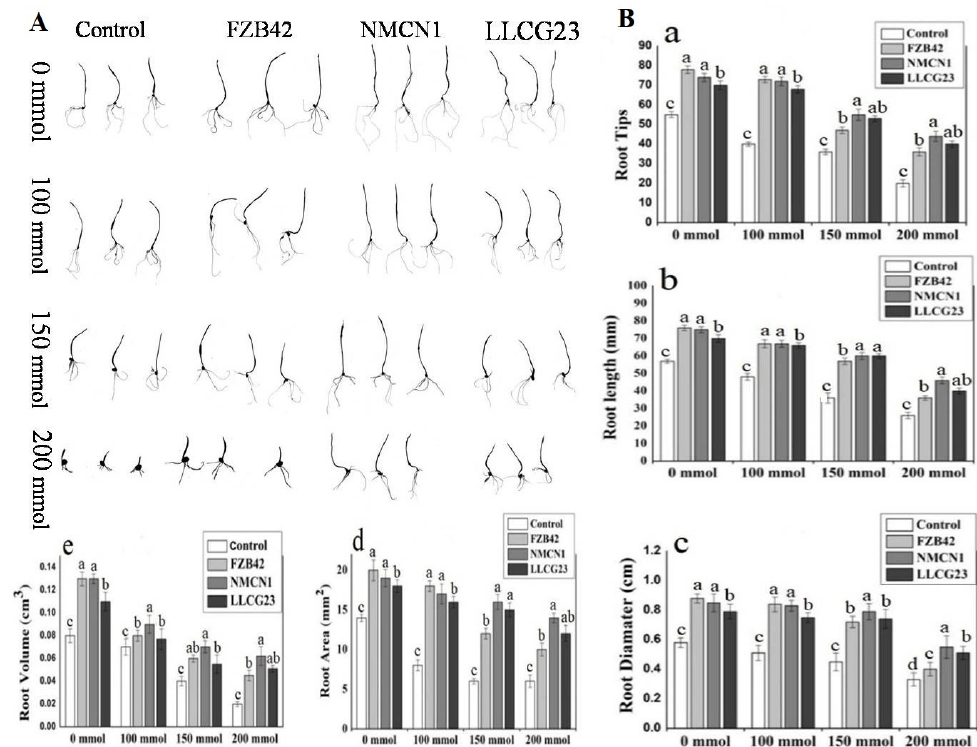
Figure 5. Rhizoscanning of wheat seedlings grown under different saline conditions (0 mmol–200 mmol NaCl) at 25 °C for 7 days insulated with Bacillus spp. strains. ( A ) Rhizoscanning in image form of wheat seedlings grown under different saline conditions at 25 °C. ( B ) Morphological root parameters such as ( a ) Root Tips, ( b ) Root Length (mm), ( c ) Root Diameter (cm), ( d ) Root Area (mm 2 ), ( e ) Root Volume (cm 3 ). The small letters on the bars indicate significant difference among the treatments calculated through Tukey’s HSD test at p ≤ 0.05 and the experiment was repeated thrice with three replicates for each treatment.